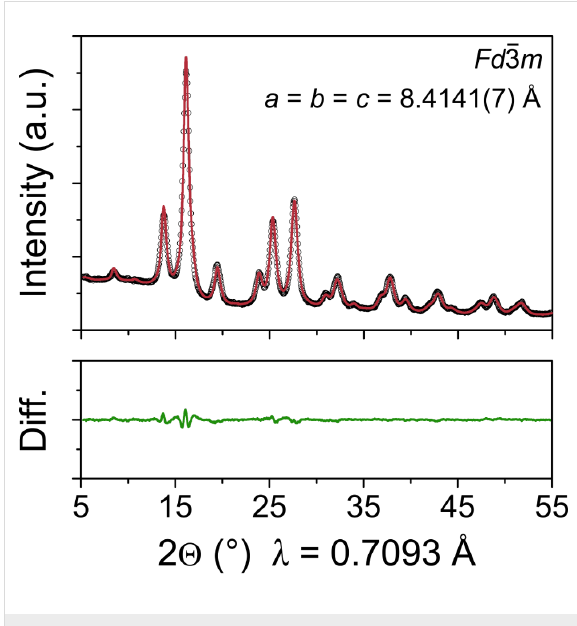
Figure 2: Observed (open circles) and calculated (red line) XRD patterns of as-prepared ZFO nanoparticles. The difference profile of the fit is shown in